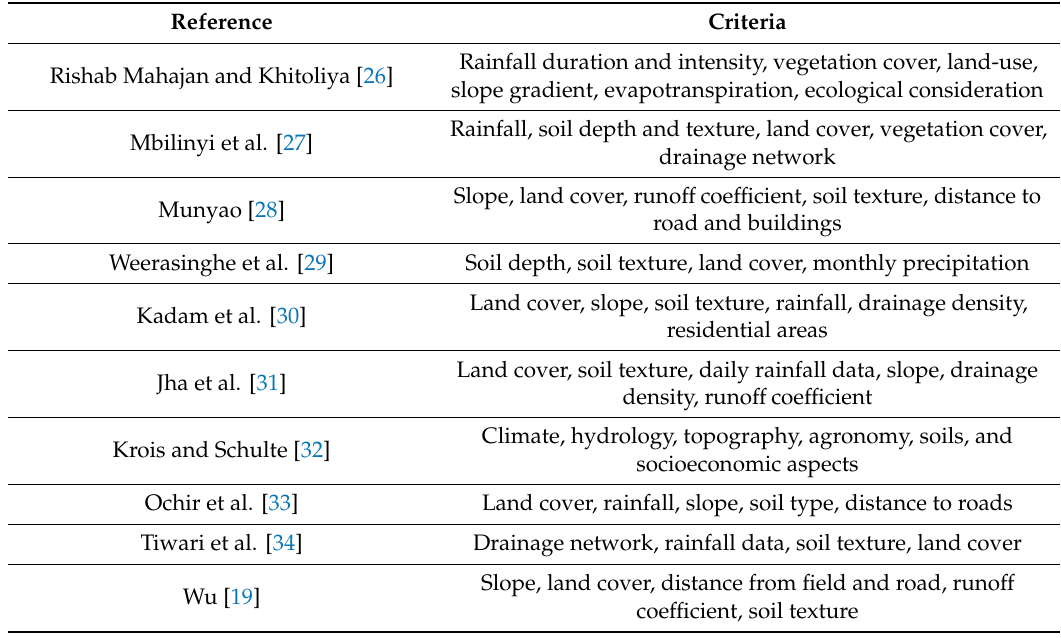
Table 1. Criteria used in the literature for runo ff harvesting site